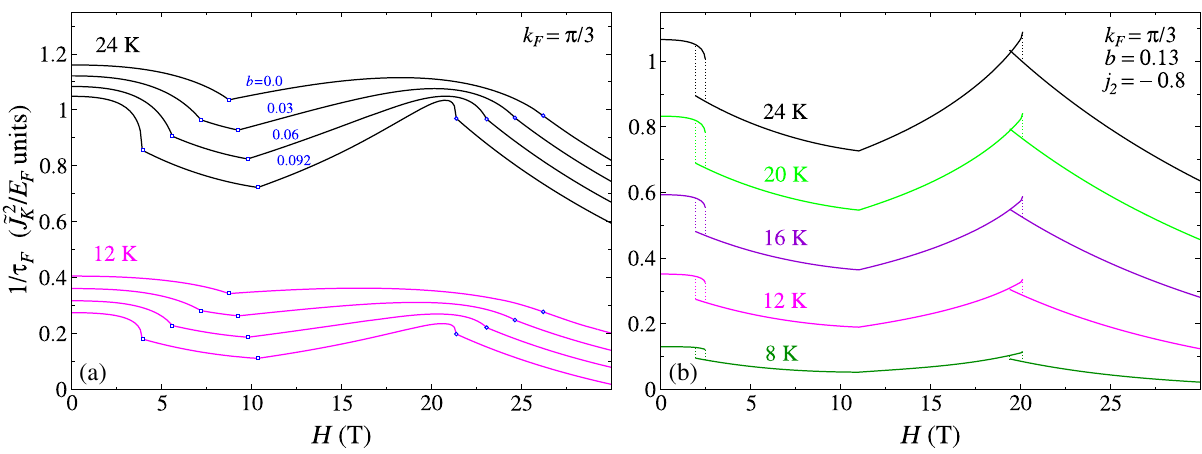
π = 3 and temperatures. Exchange parameters are from Table I. FIG. 10. We show 1 = τ vs H from Eq. (37) for representative k F F ¼ (a) Results for the biquadratic exchange b ¼ 0 , 0.03, 0.06, and 0.0922 displaced down for clarity by increments of 0.05 in the given units. Circles and squares mark transitions between magnetic phases. (b) b ¼ 0 . 13 , j 2 ¼ 0 . 08 . Dotted lines indicate